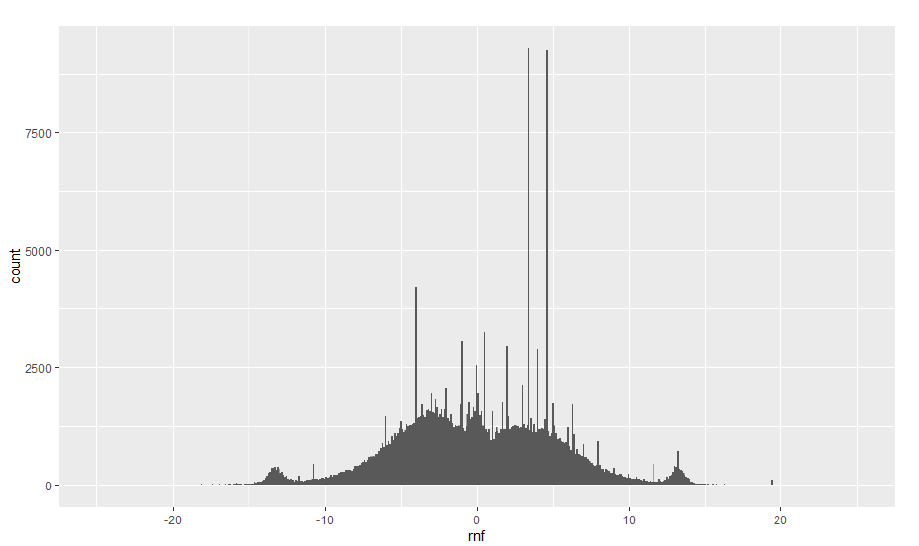
Figure 10. Changes in direction of shearer movement. Source: Own study.